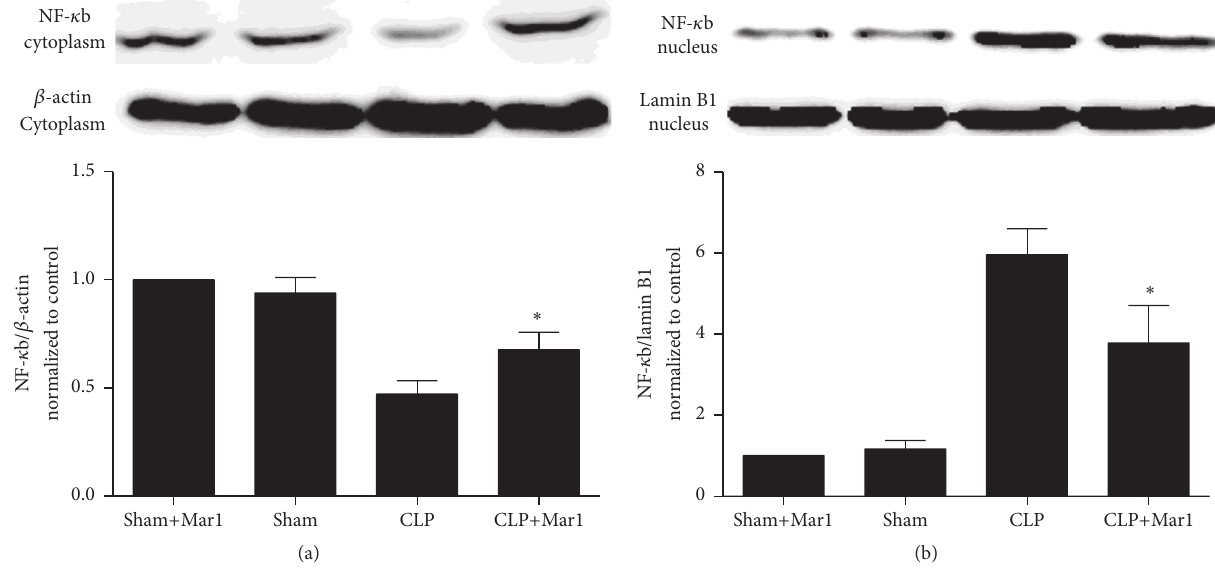
Figure 6: Translocation of PBMC NF- 𝜅 B p65 subunit was inhibited by Mar1 in CLP mice. (a) NF- 𝜅 B p65 in cytoplasm decreased after CLP surgery but increased by Mar1. (b) NF- 𝜅 B p65 increased in CLP mice, but Mar1 decreased level of NF- 𝜅 B p65 in nucleus. NF- 𝜅 B p65 band from the experiments was normalized by 𝛽 -actin or lamin B1. 𝑛 = 6 . Data are expressed as means ± SEM. ∗ 𝑃 < 0.05 versus the CLP